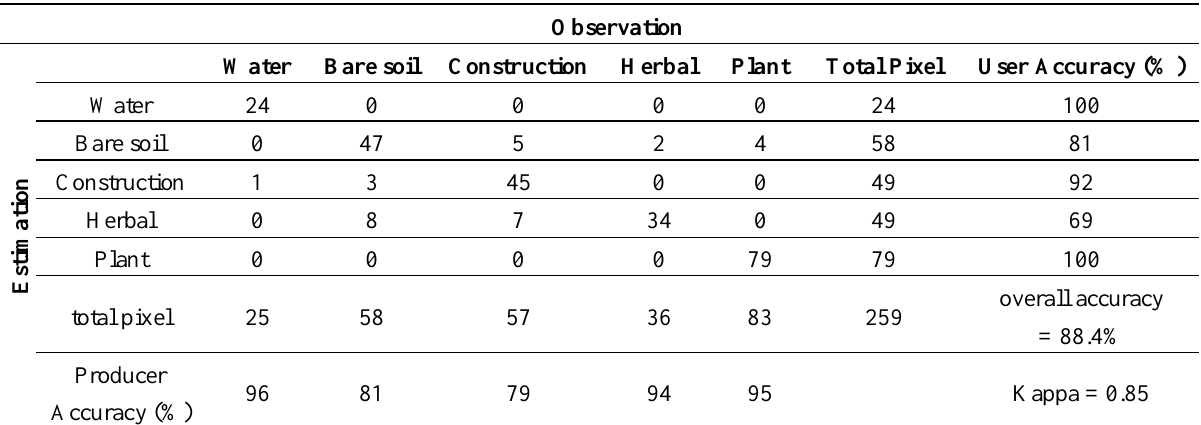
Table 1. Summary of accuracy and error source.